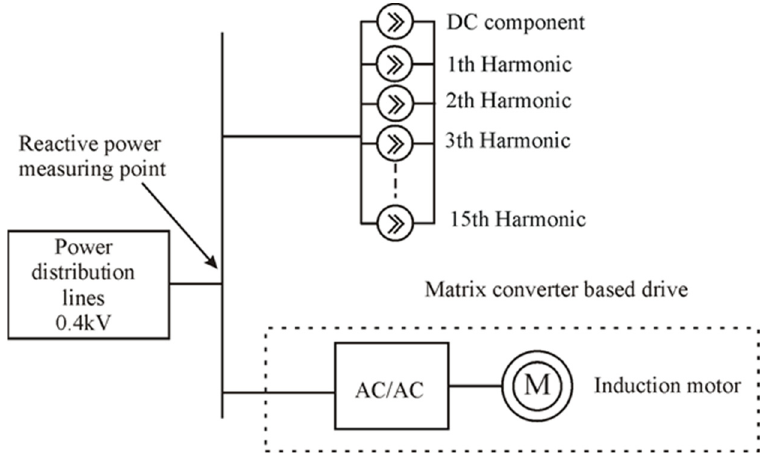
Table 4. Values of the harmonics for accurate reproduction of the input current of the LED wall display.